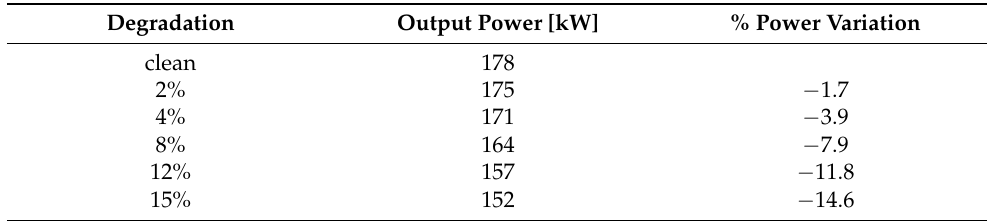
Figure 10. Turbine inlet and exit temperatures for damaged compressor. Table 7. Power reduction with increasing compressor degradation for operating point (PLA) of about 50%, altitude h = 50 m and Mach = 0.09, at 6000 rpm.